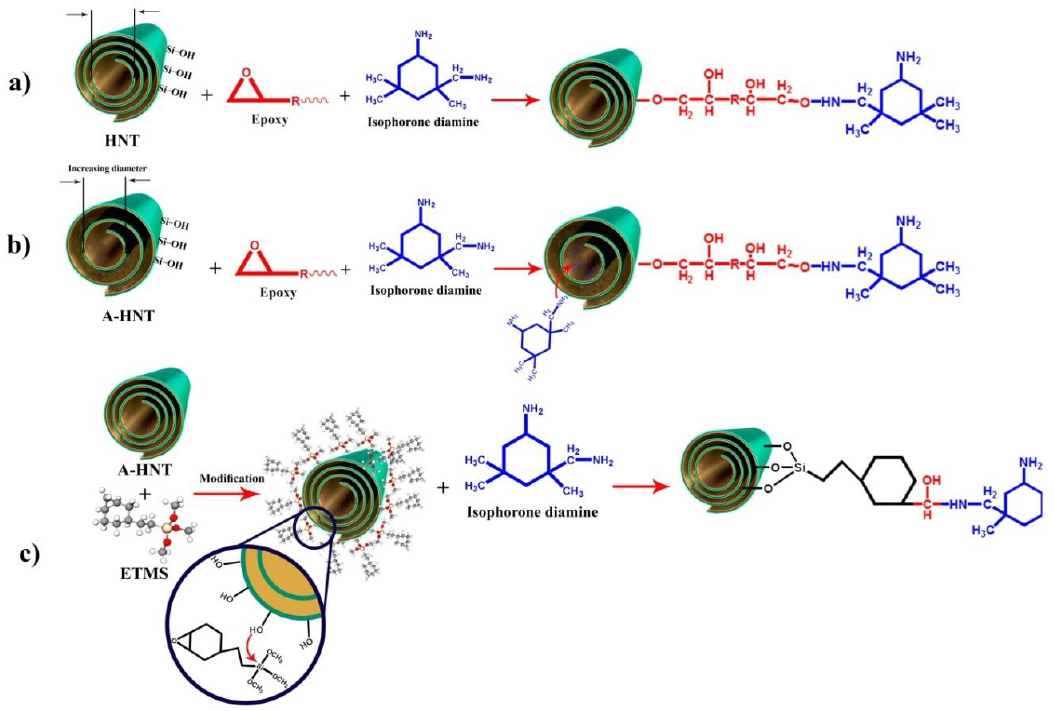
Figure 6. Possible reaction of ( a ) P-HNT and epoxy, ( b ) A-HNT with epoxy and amine curing agent and ( c ) F-HNT with amine group of curing agent.